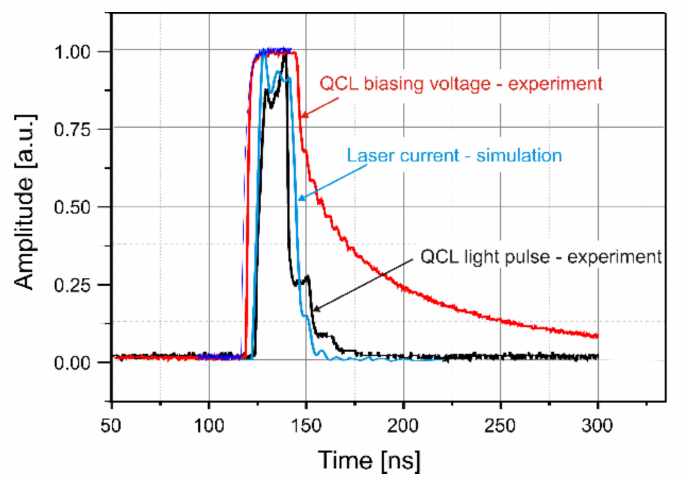
Figure 7. Comparison of experimental results (laser biasing voltage and light pulse) with simulation results (laser